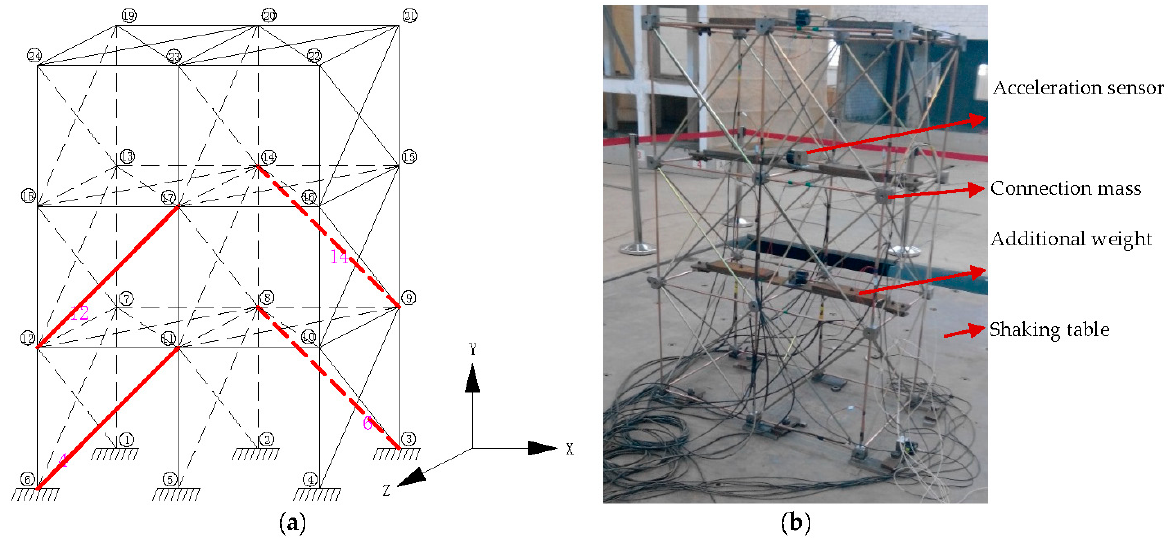
Figure 13. Spatial structure model with 4 austenite SMA wires ( a ) optimal position and ( b ) shaking table test.